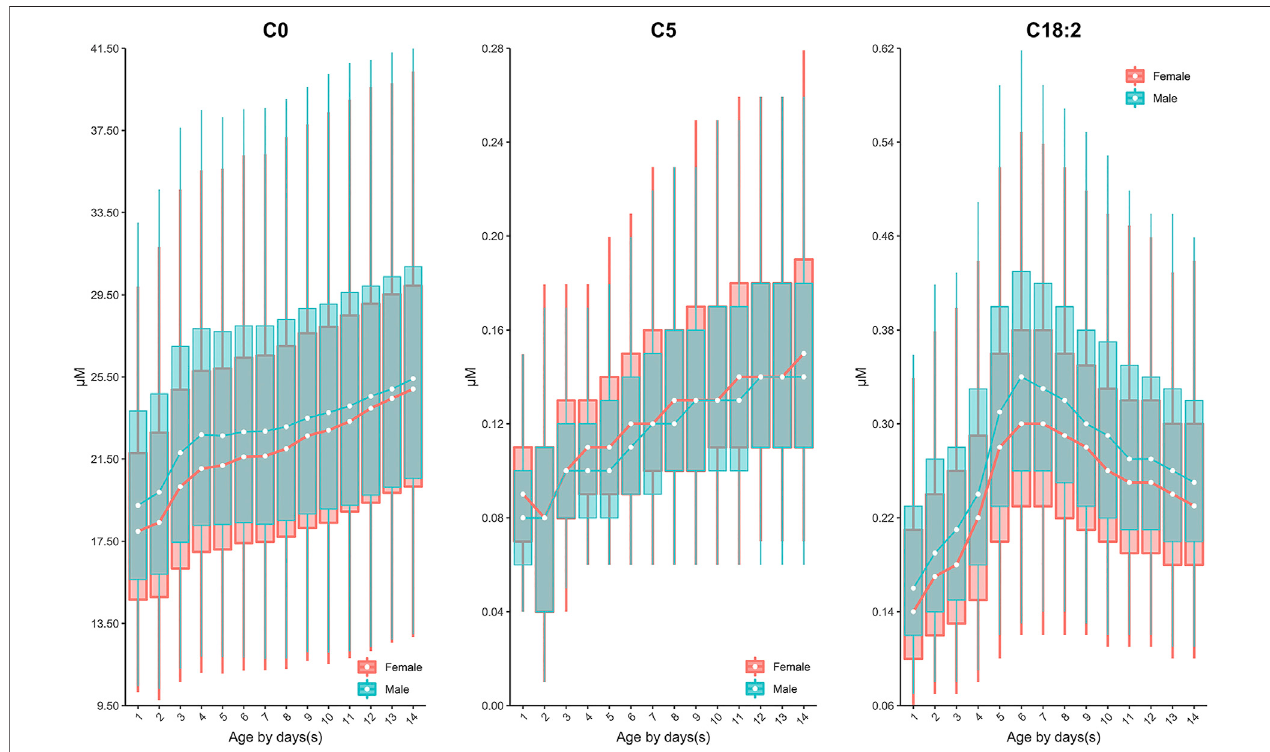
FIGURE 4 | The dynamic change of C0, C5, C18:2 over age and sex. The data of male and female partitions are shown in green and red boxes with whiskers, respectively.Theboxesextendfromthe25 th tothe75 th percentile,withwhiskersextendingtothe2.5 th or97.5 th percentile.Themediansareshownaswhitecirclesinthe body of the boxes, and are linked with green (male) or red (female) line to shown the dynamic trends over age. Abbreviations are listed in the legend of Table 2 .